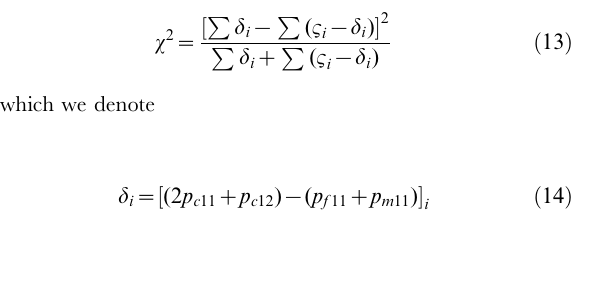
Table 3. Calculation of b i and c i in terms of dosage probabilities and t for the i th trio with all 11 TDT-informative transmissions.